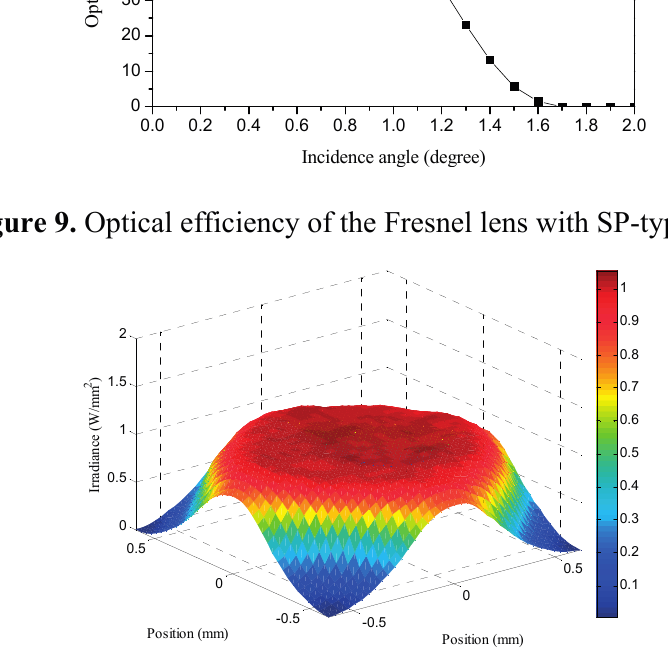
Figure 10. Irradiance distribution on the receiver under normal incidence for the